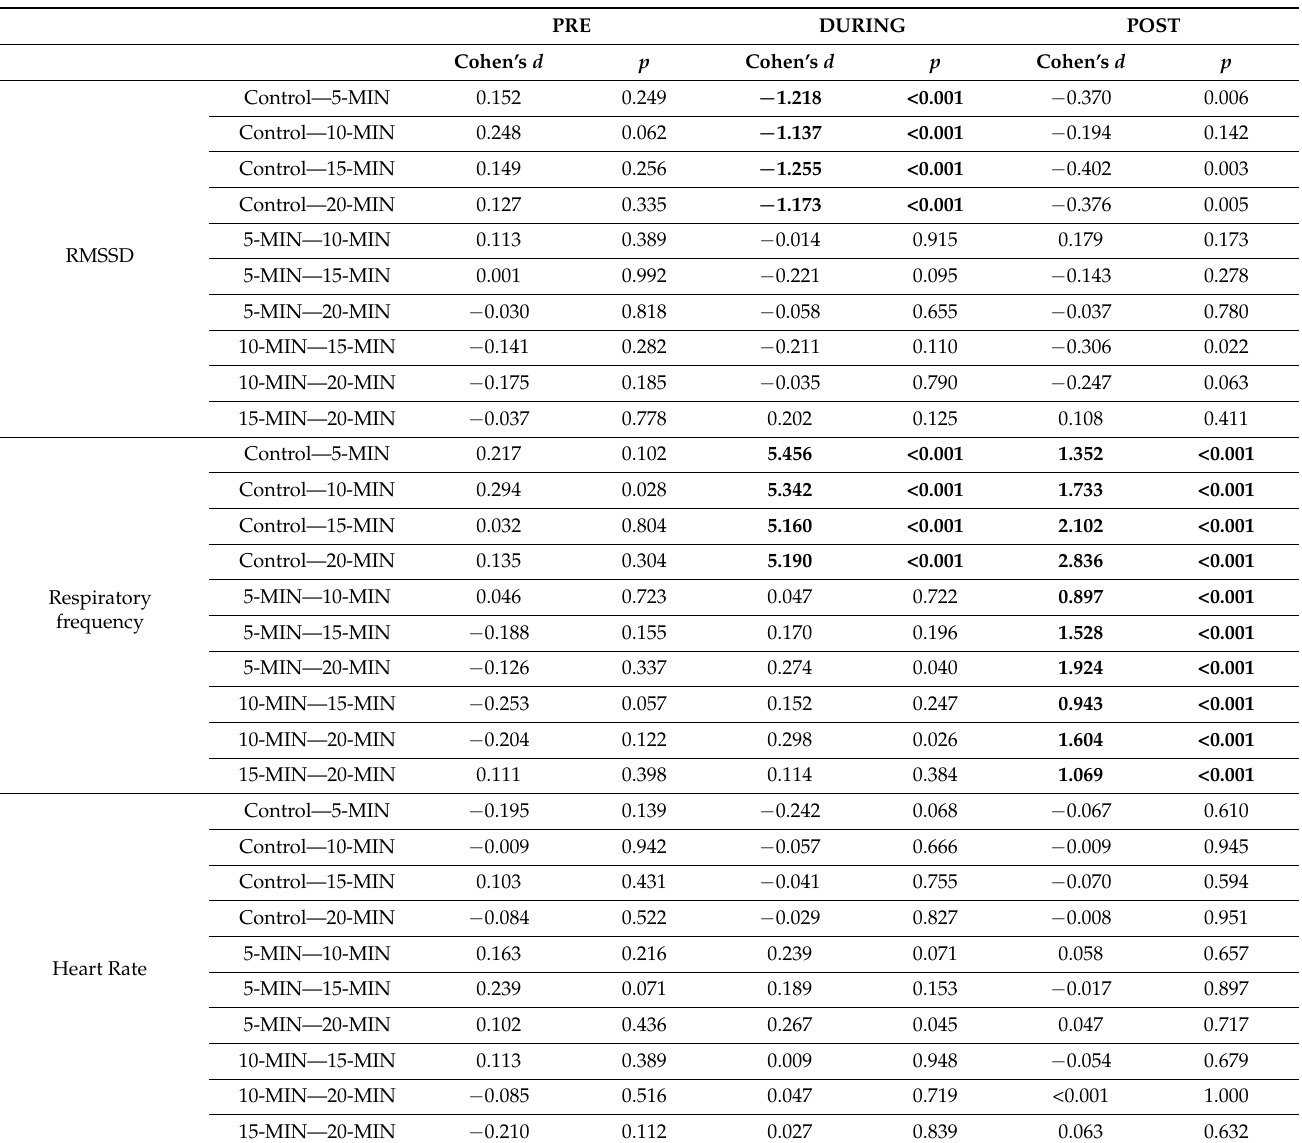
Table 3. Mean comparisons between conditions—control, 5-MIN, 10-MIN, 15-MIN,